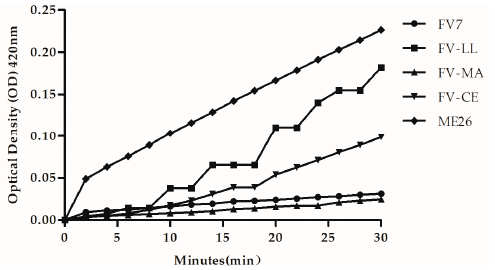
Figure 5. The inner membrane permeability of the peptides. The hydrolysis of o -Nitrophenyl- β - D -galactopyranoside (ONPG) due to release of cytoplasmic β -galactosidase of E. coli UB1005 treated by 1× MIC peptides was measured spectroscopically at absorbance of 420 nm as a function of time.